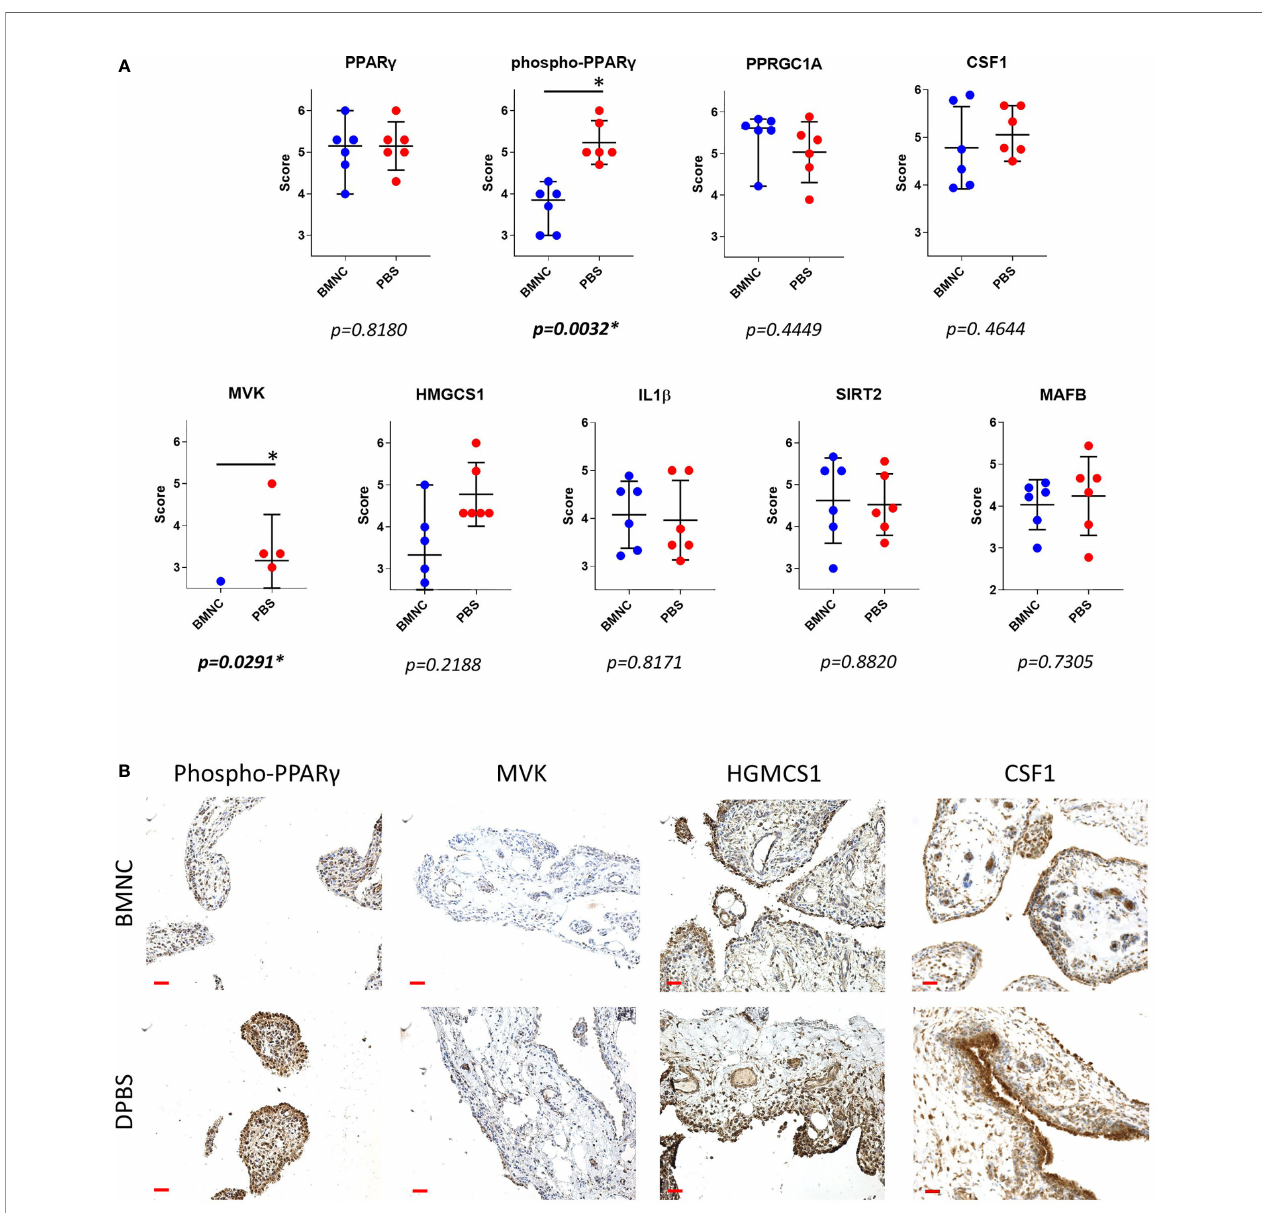
FIGURE 8 | Immunohistochemistry of synovial membranes from 6 horses with experimental synovitis treated with BMNC or DPBS. Marked resolution of in fl ammation was evident following BMNC therapy (31). Selected targets were potential upstream regulators of high network interaction that were differentially expressed in ISF cultures over consecutive time points, or central drivers of most activated pathways. (A) Scatterplots of composite staining scores (median, 95% con fi dence interval) for PPAR g ( PPARG gene ), phosphorylated PPAR g , PPAR g co-activator 1 alpha ( PPARGC1A gene ), colony stimulating factor 1 ( CSF1 gene ), mevalonate kinase ( MVK gene ), 3-Hydroxy-3-Methylglutaryl-Coenzyme A Synthase 1 ( HMGCS1 gene ), interleukin-1 b ( IL-1 b gene ), sirtuin 2 ( SIRT2 gene ), and transcription factor MAFB ( MAFB gene ). Each dot in the scatterplot represents the composite score for each individual horse. Tissue expression for phosphorylated PPAR g ( p=0.0032 ) and mevalonate kinase ( p=0.0291 ) were lower in BMNC-treated joints. (B) Representative sections of synovium from in fl amed joints treated with BMNC or DPBS and stained for selected markers detailed above (scale bars